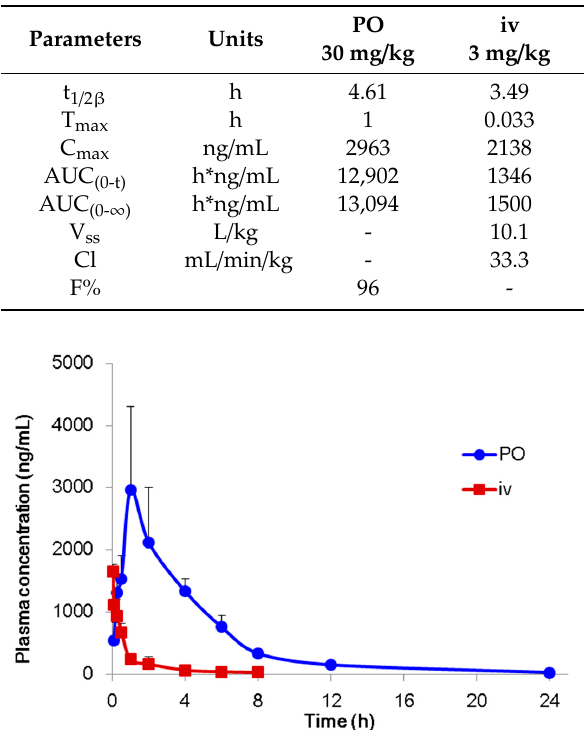
Figure 3. Mean plasma concentration-time profile in male ICR mice after administration of a single oral (30 mg / kg) or intravenous (3 mg / kg) dose of compound DX-03-12. PO stands for per os, which oral (30 mg/kg) or intravenous (3 mg/kg) dose of compound DX-03-12. PO stands for per os, which means oral administration of drug; iv stands for intravenous administration of drug. means oral administration of drug; iv stands for intravenous administration of